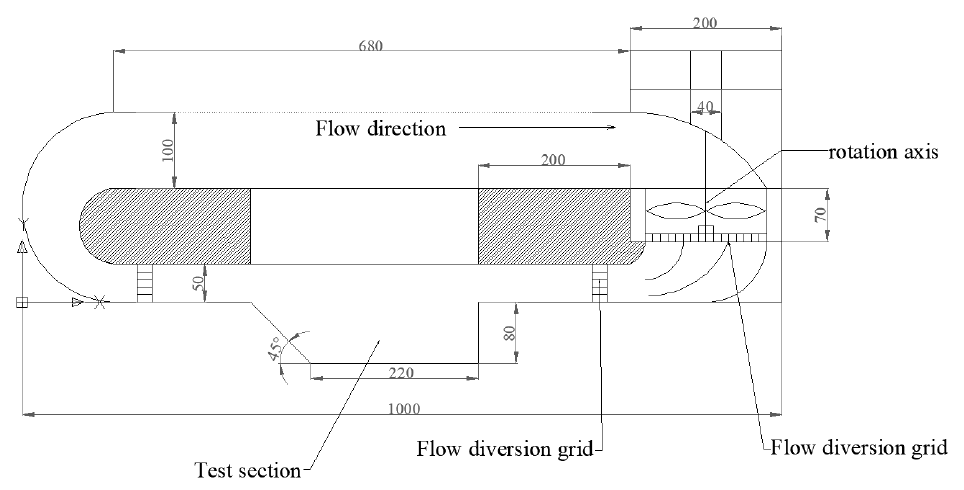
Figure 2. Front view of experimental tank (unit: mm).